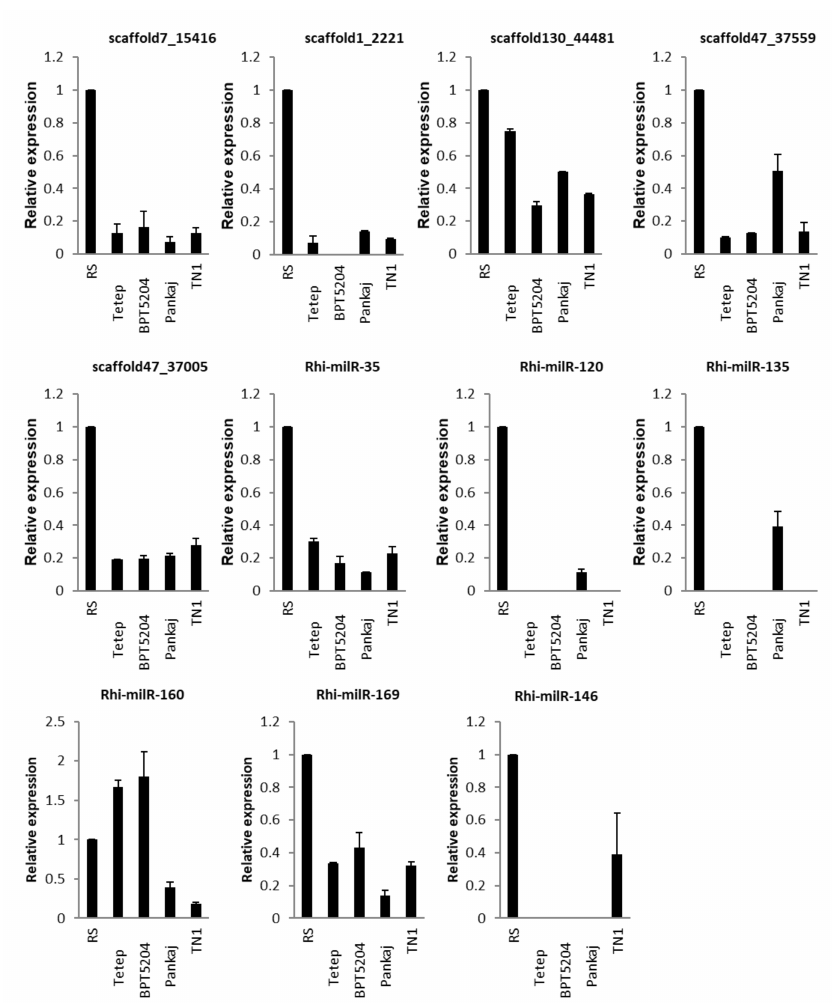
Figure 4. qRT-PCR expression analysis of milRNAs in different rice genotypes after R. solani inocula- tion. X-axis: samples ( R. solani inoculated sheath tissue of four rice genotypes); Y-axis: Expression level of the individual milRNA relative to its expression in R. solani grown in PDA. Error bars indicate the mean ± S.E. of three biological